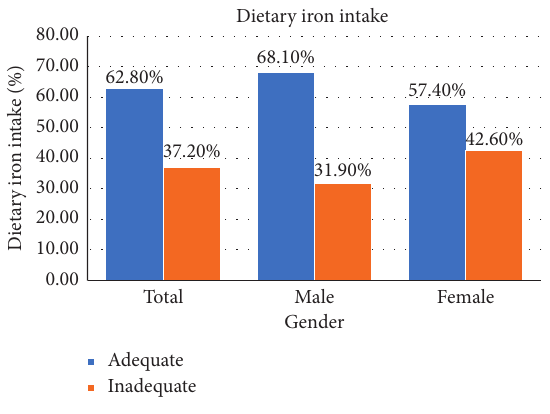
Figure 1: Dietary iron status by